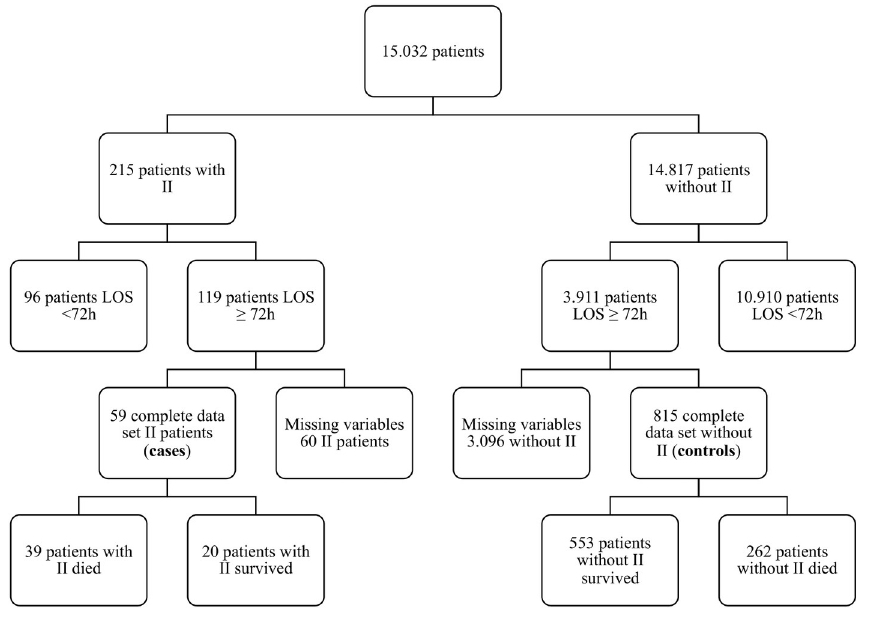
Fig 1. Patient selection flow diagram. II = intestinal ischemia, LOS = length of stay, h = hour.